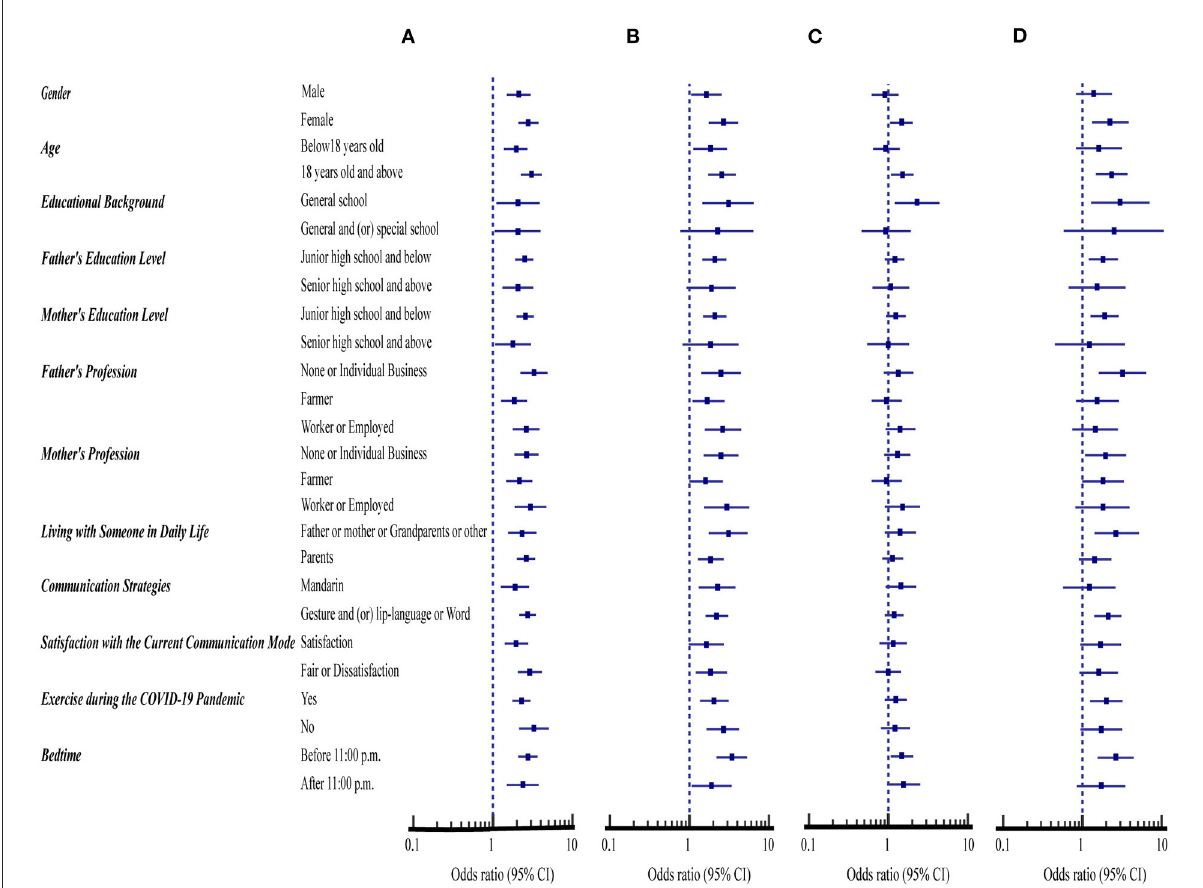
FIGURE1 Comparison of demographic variables with the compliance with four health measures between students with normal hearing (SNH, n = 1,104) and with hearing disability (SHD, n = 485). (A) Avoiding sharing of utensils during mealtime. (B) Washing hands with soap and water. (C) Washing hands immediately after coughing, or sneezing, rubbing the nose. (D) Wearing masks with or without the pandemic